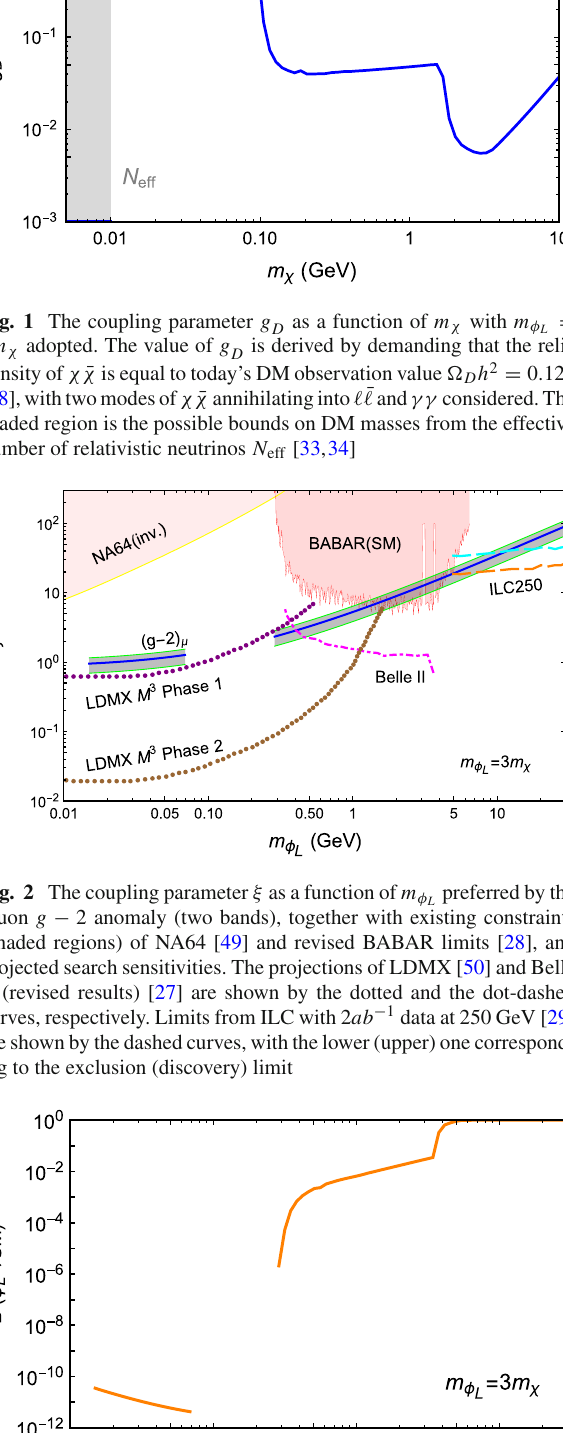
Fig. 3 The branching ratio B ( φ L → SM) of φ L decaying into SM = 3 m χ particles with m φ L